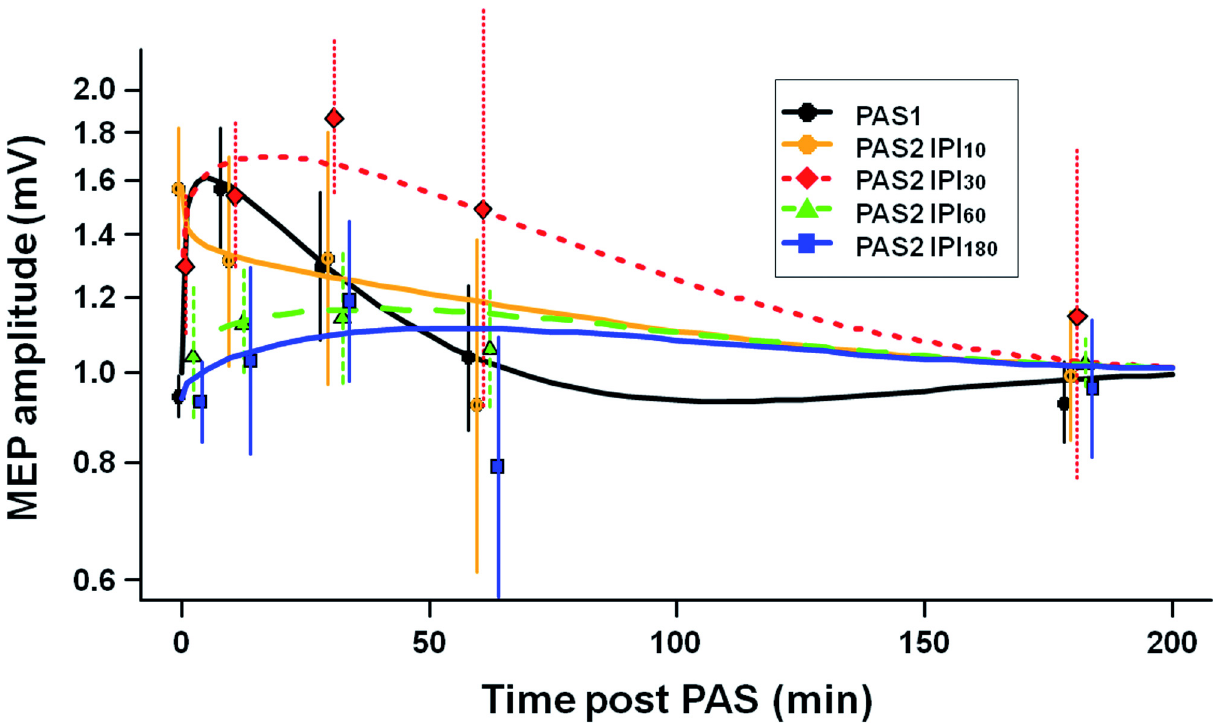
Fig 5. Computational modeling of the time course of PAS 1 and PAS 2 effects. MEP amplitudes as a function of time modeled from the experimental MEP raw data independently for PAS 1 and PAS 2 at all IPIs. PAS 1 and PAS 2 model functions, i.e. the time course of MEP amplitude changes after PAS 1 vs. those after PAS 2 , were significantly different at all IPIs ( P < 0.0001 each). In addition, PAS 2 effects at IPI 10 and IPI 30 were significantly different from PAS 2 effects at IPI 60 and IPI 180 ( P < 0.0001), and PAS 2 effects at IPI 10 from PAS 2 effects at IPI 30 ( P = 0.033), but not PAS 2 effects at IPI 60 from those at IPI 180 ( P > 0.5). Experimental data are shown as mean ± SEM. Note that data for PAS 2 at time points 60min and 180min post PAS 2 are from six subjects only, whereas all other data are from twelve subjects (see Material and Methods). Y-axis, logarithmic